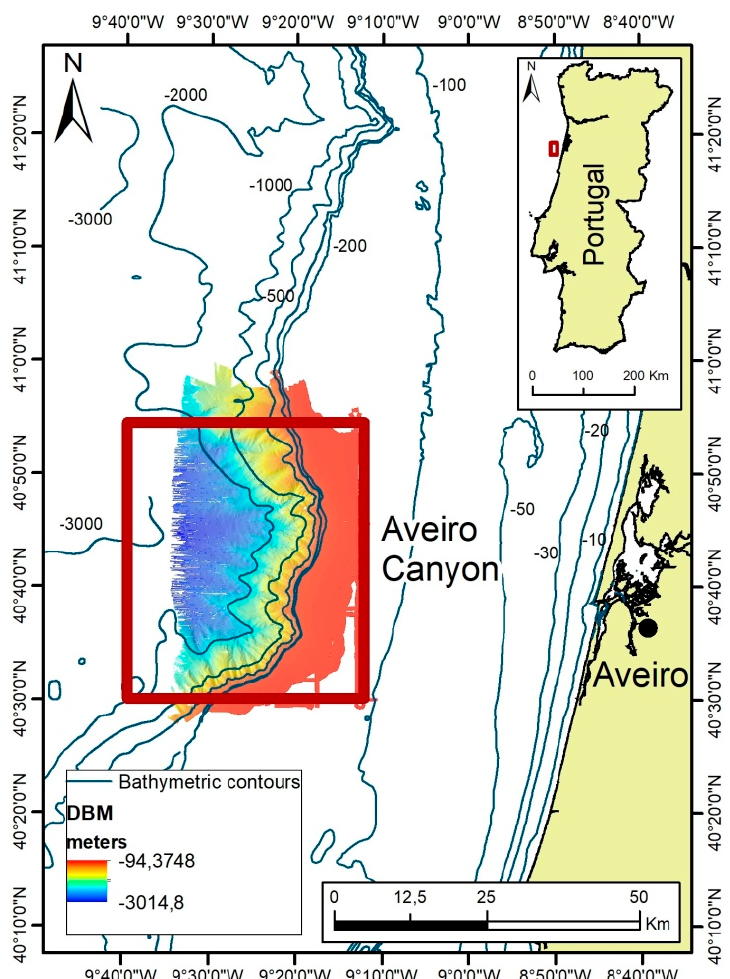
Figure 1. Location of the study area—submarine Aveiro Canyon.